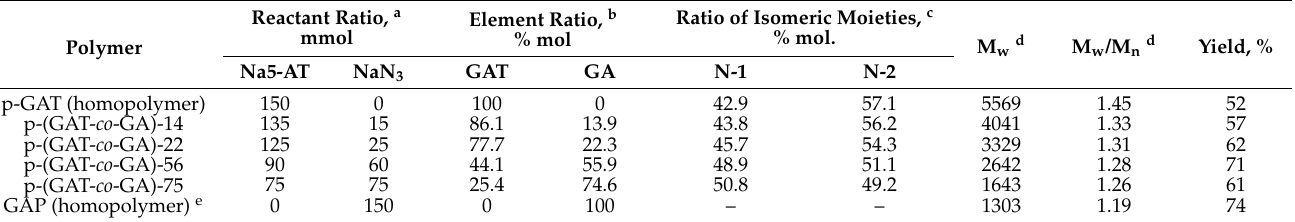
Synthesis data and structural characteristics of the p-(GAT), p-(GAT- co -GA) and GAP